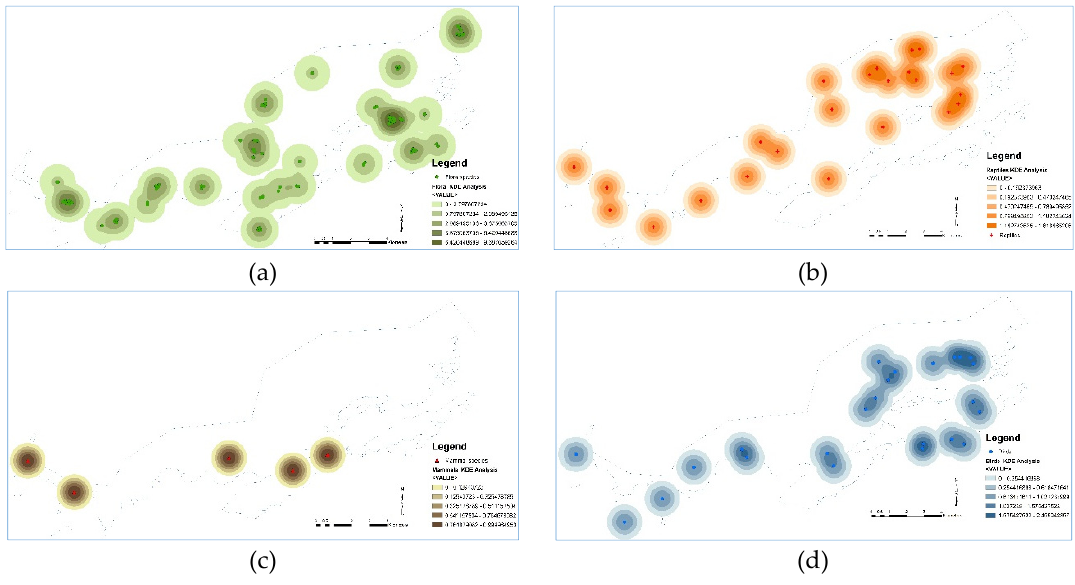
Figure 11. Results of KDE analysis with 1000 m radius results classified according to natural breaks for: (a) endemic flora locations; (b) reptiles and amphibians; (c) mammals; and (d) birds.